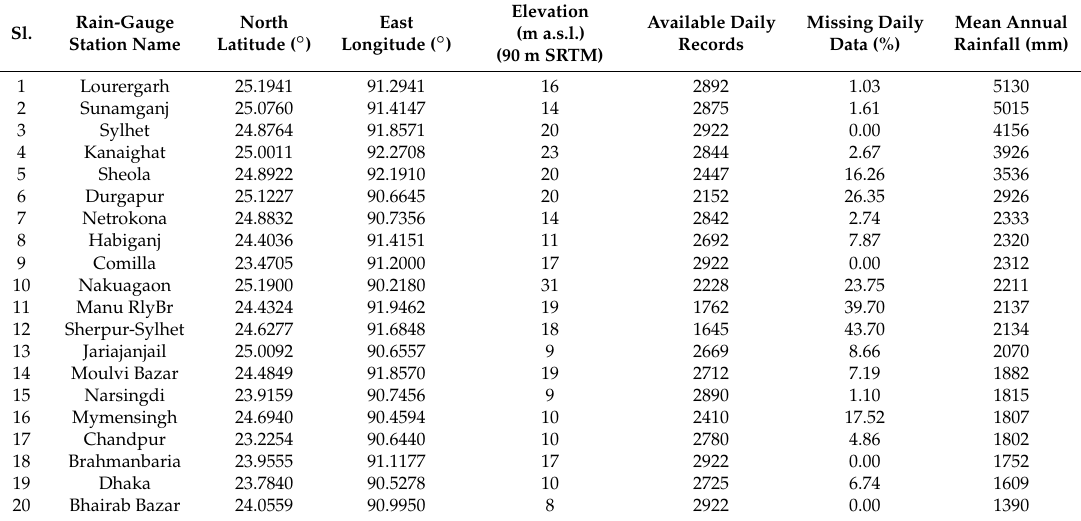
Table 1. Salient features of the 20 rain-gauge stations located in the Bangladesh portion of the Meghna basin for the study period of 2009–2016. See Figure 1b for a spatial reference.